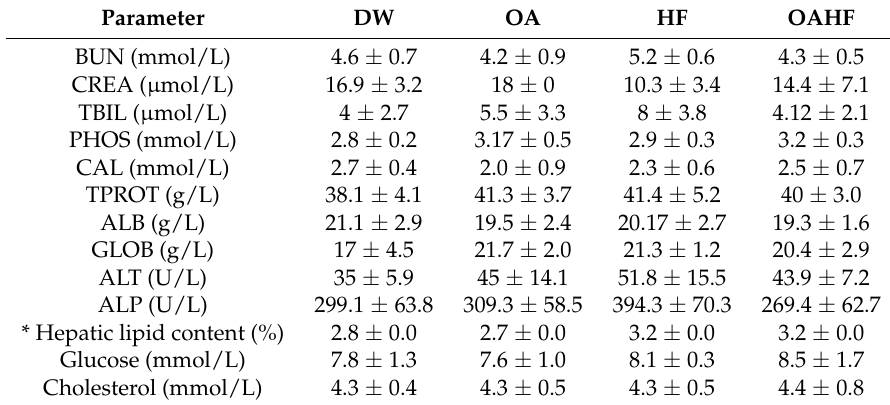
Table 3. The effects of neonatal oral administration of oleanolic acid on biomarkers of renal and hepatic function, hepatic lipid storage, general clinical biochemistry and the concentrations of circulating metabolic substrates in suckling male and female